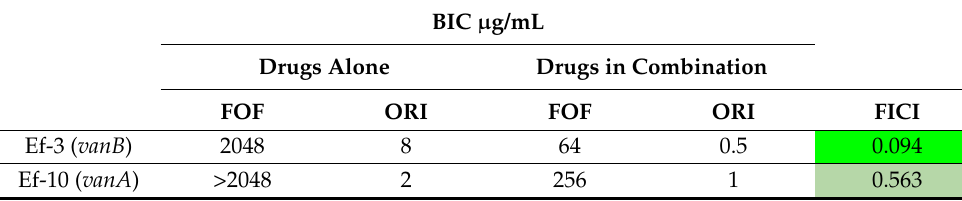
Table 2. BIC values of fosfomycin (FOF) and oritavancin (ORI), alone and in combination, on two representative isolates, and the resulting FICI values (light green: synergistic effect; dark green: additive effect) . Mode values of two independent experiments, carried out in triplicate, are re- ported.